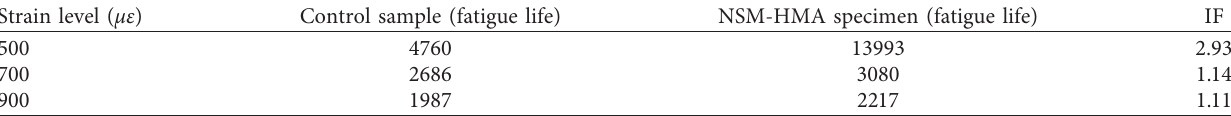
Table 5: Ratio of the number of load repetitions in the asphalt mixture specimens modified with nanosilica to the control specimen. Strain level ( με )